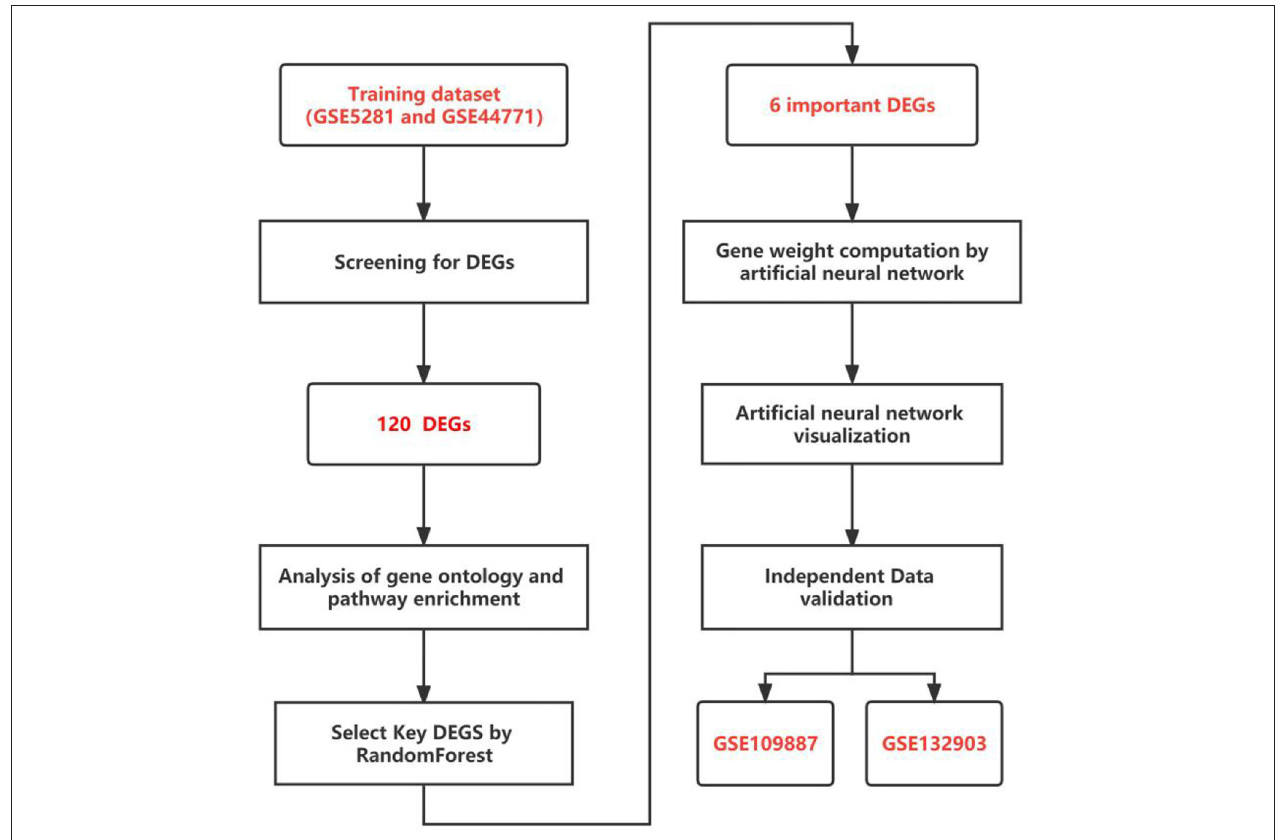
FIGURE 1 | The flow chart of the